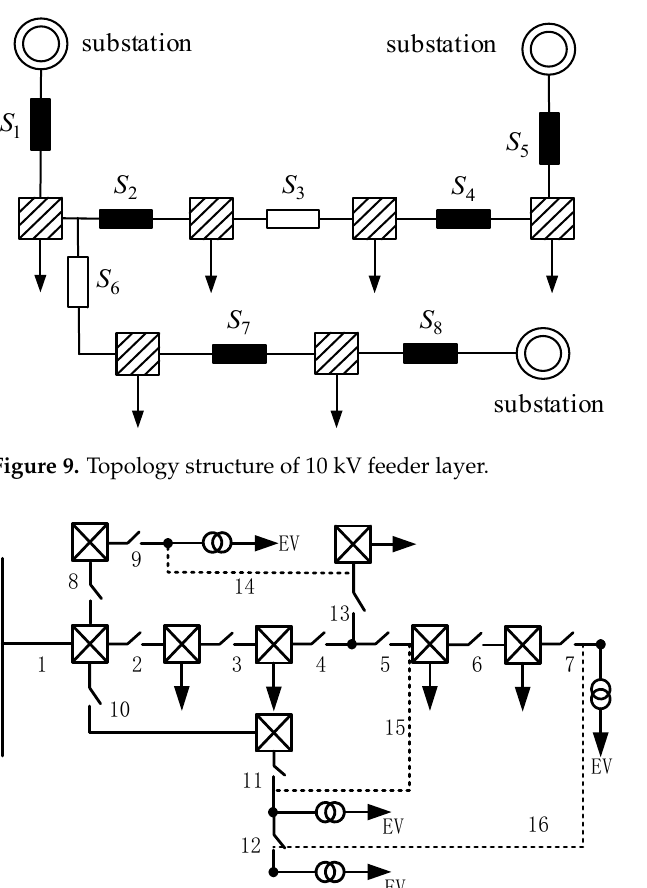
Table 1. Comparison of feeder layer load balance.